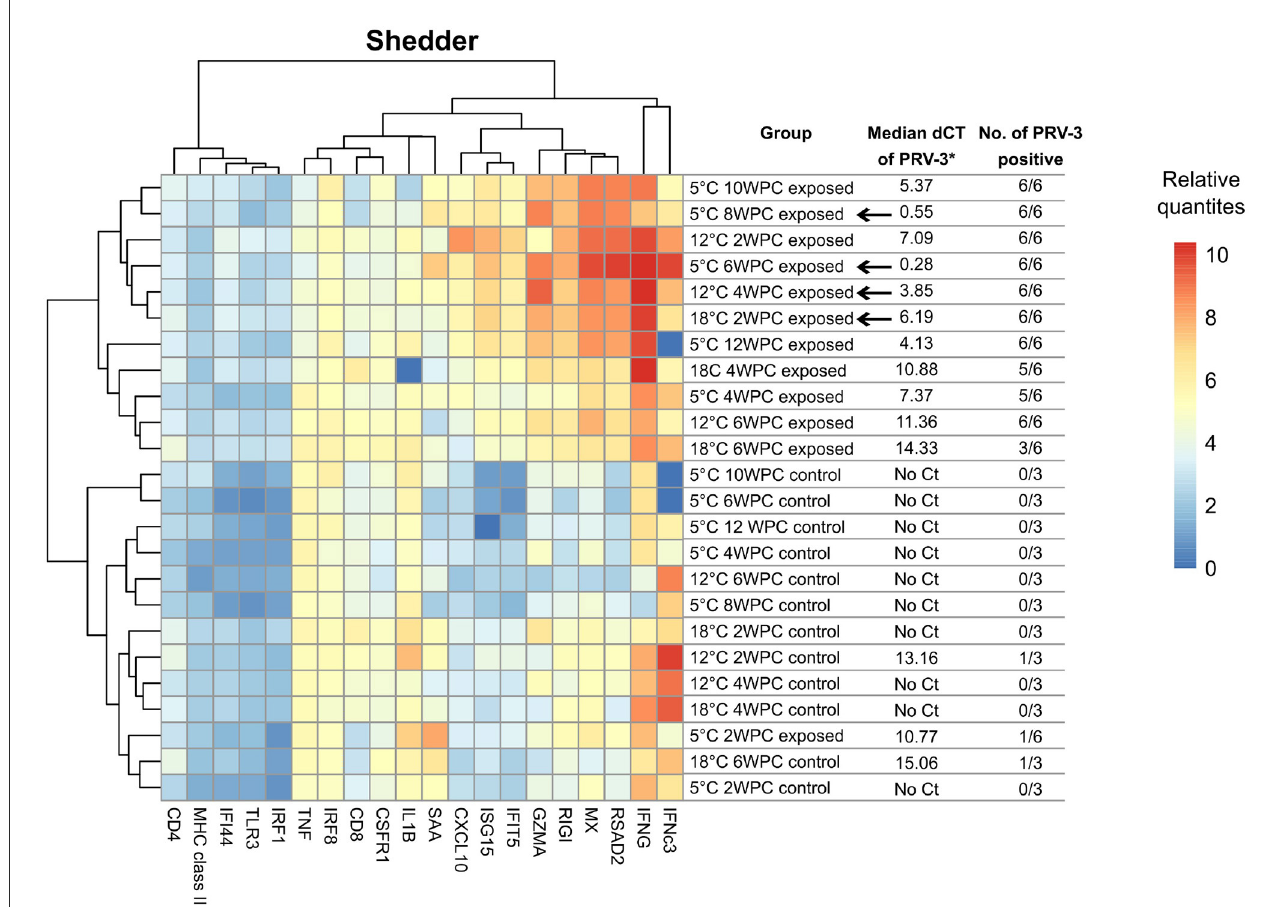
FIGURE6 Heatmap of median log2 transformed relative quantities of immune gene expression profiles of selected cohabitant groups. Arrows indicate time point for peak in virus load. ∗ Low value corresponds to high virus load (dCt = Ct[PRV-3] − Ct[Reference gene]). SD values of each group are shown in Supplementary material.